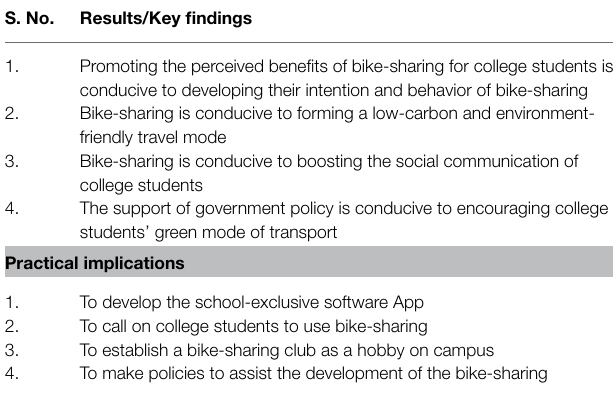
TABLE 7 | Summary of the key findings and practical